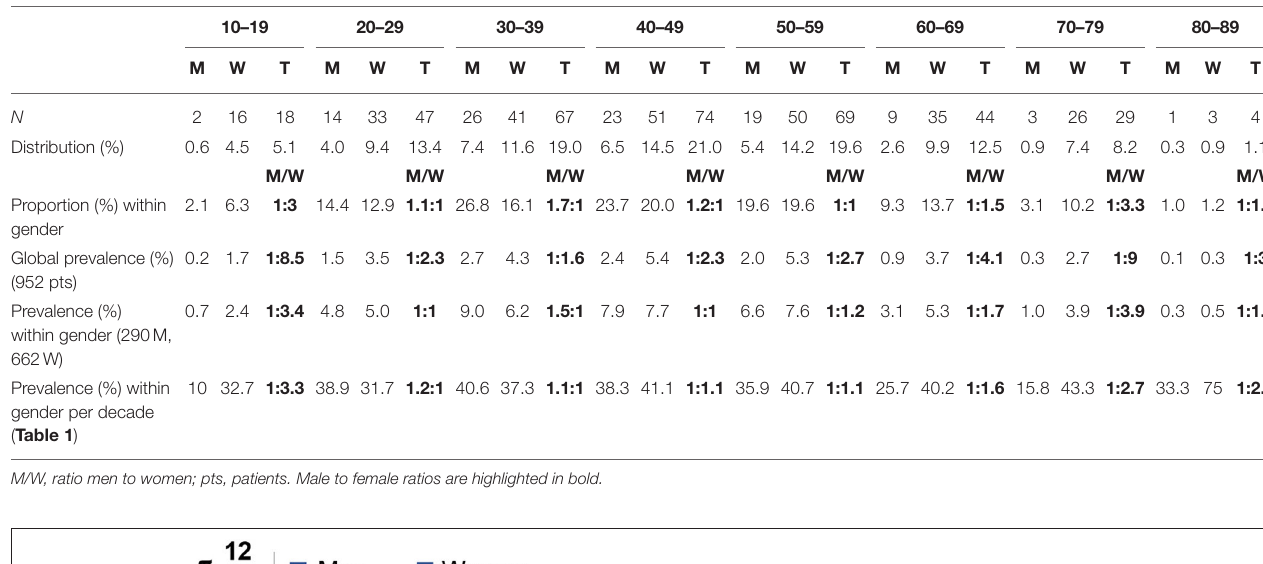
TABLE 3 | Patient numbers (N), distribution, proportion within gender, and prevalence of patients responding positively to the screening question on insomnia and/or hypersomnia, stratified per decade and by gender.